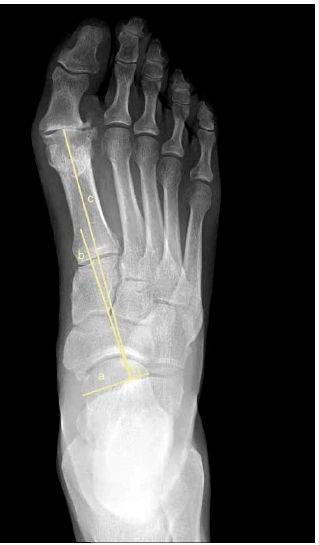
Figure 10. Dorsoplantar weight-bearing radiograph of Simons’ angle.